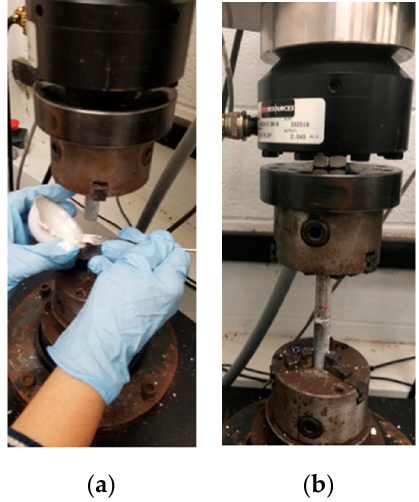
Figure 4. Preparation of cemented rod samples in UTM: ( a ) cement pouring on top of the bottom rod and ( b ) a cemented rod sample pointing to gaps filled by cement. and ( b ) a cemented rod sample pointing to gaps filled by